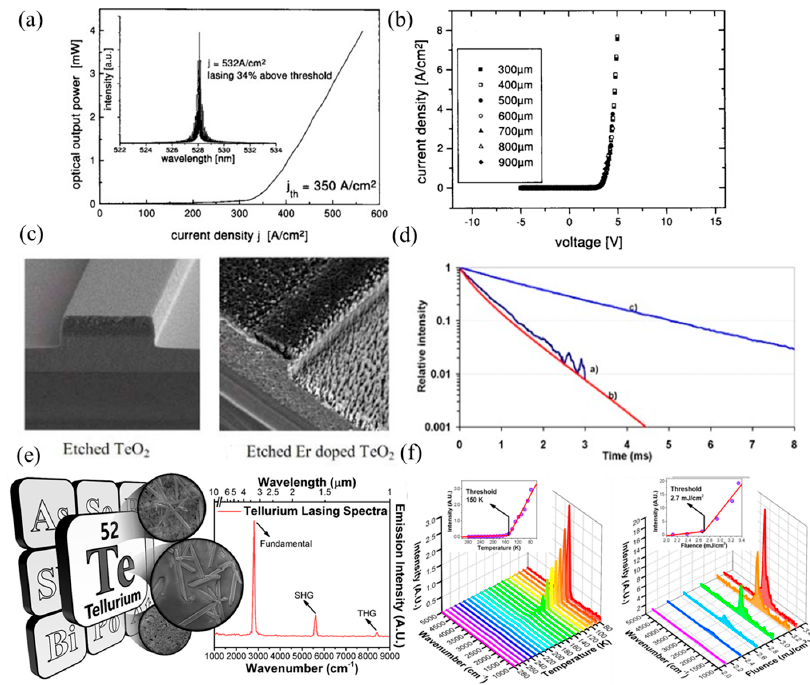
Figure 3. ( a ) Power/current curve and emission spectra of ZnSe laser diodes with Te-terminated GaAs interface (inset). ( b ) As the electric field changes, the Te-started laser diode is displayed [189]. Copyright 1998 Elsevier. ( c ) Etching TeO 2 waveguide and ( d ) Er-doped waveguide. ( e ) Life time variation of erbium-doped acetate film [190]. Copyright 2010 The Optical Society. ( f ) The photoluminescence of Te solid crystals in the medium wavelength infrared (MWIR) region. ( g ) Temperature variation curve of MWIR emission spectrum of Te bulk crystal. ( h ) The curve of Te bulk crystal MWIR emission spectrum with laser intensity [197]. Copyright 2019 American Chemical Society.